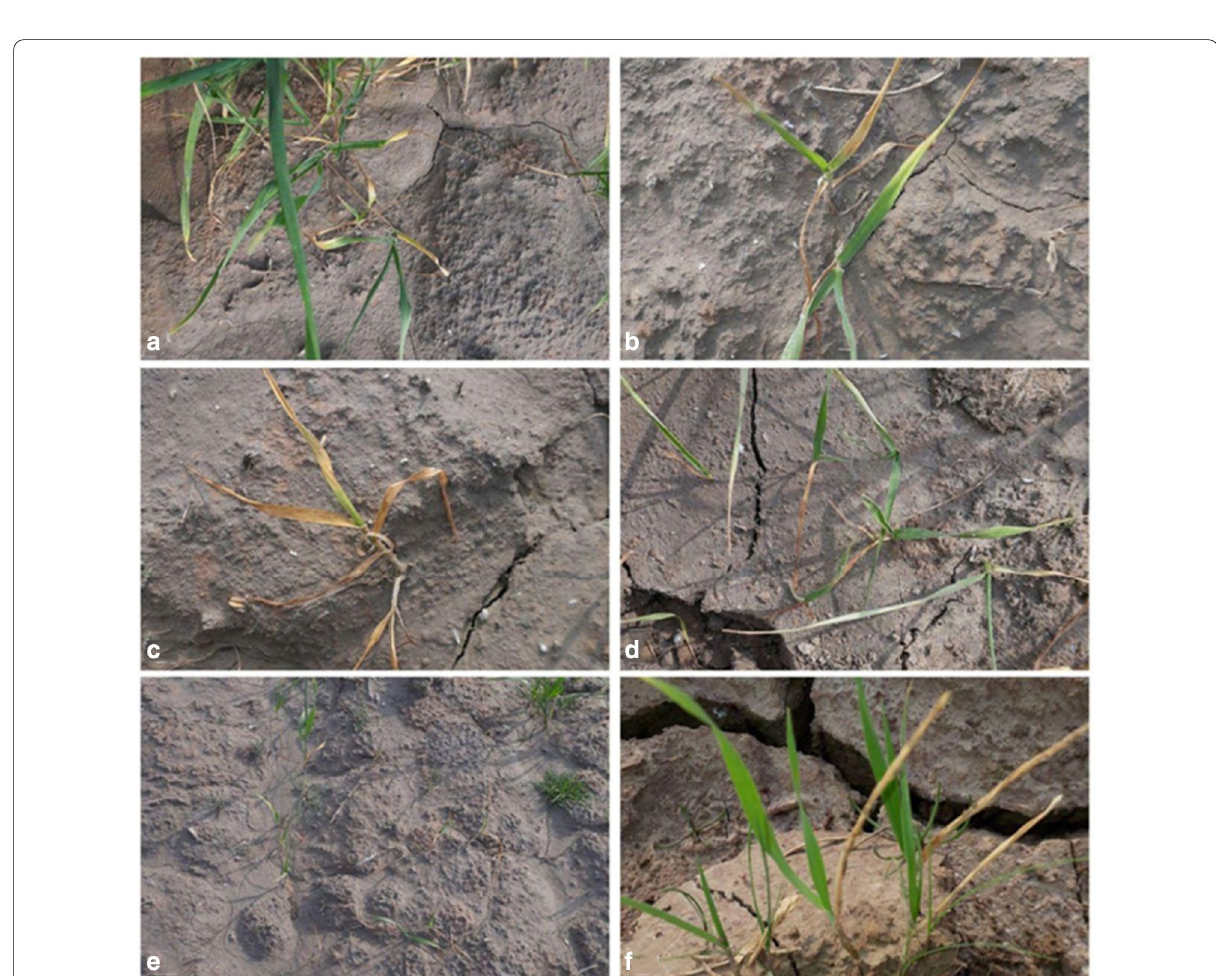
Fig. 2 Wheat damping-off symptoms on different samples from: a Al-Qurna, b Al-Madinah, c Al-Amarah, d Kumit, e Ali-Al Sharqi, f Ali-Al Gharbi